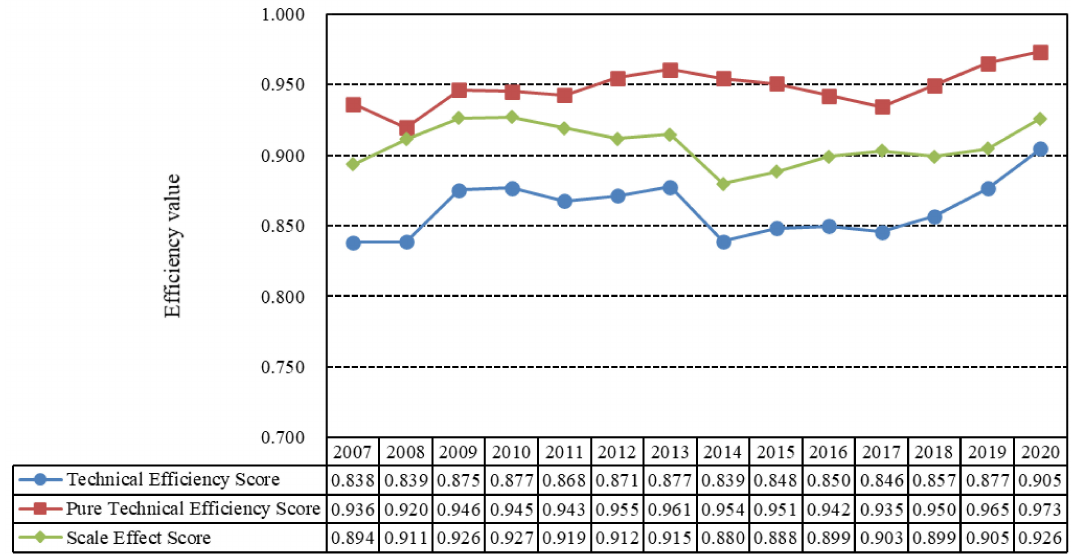
Figure 3. Temporal evolution of the cities’ EWP from 2007 to 2020, and its decomposition.